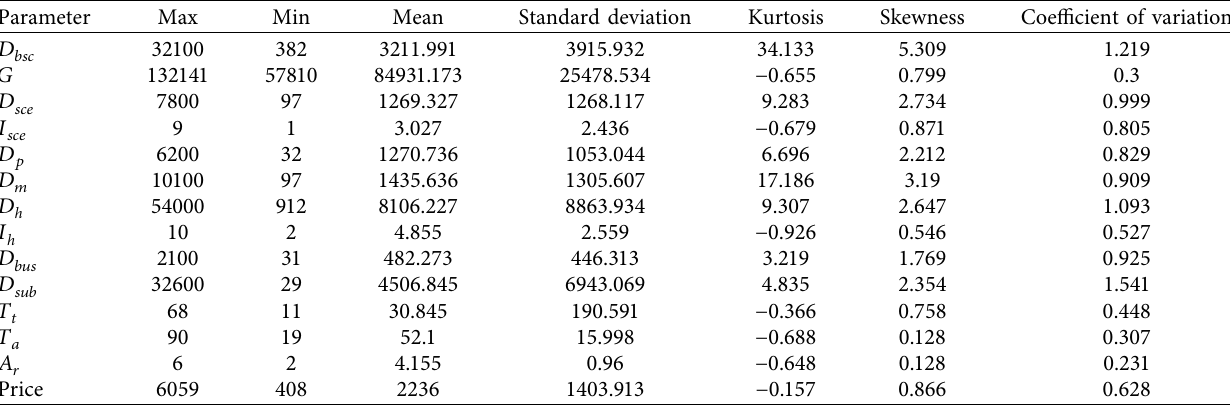
Table 5: Descriptive statistics.